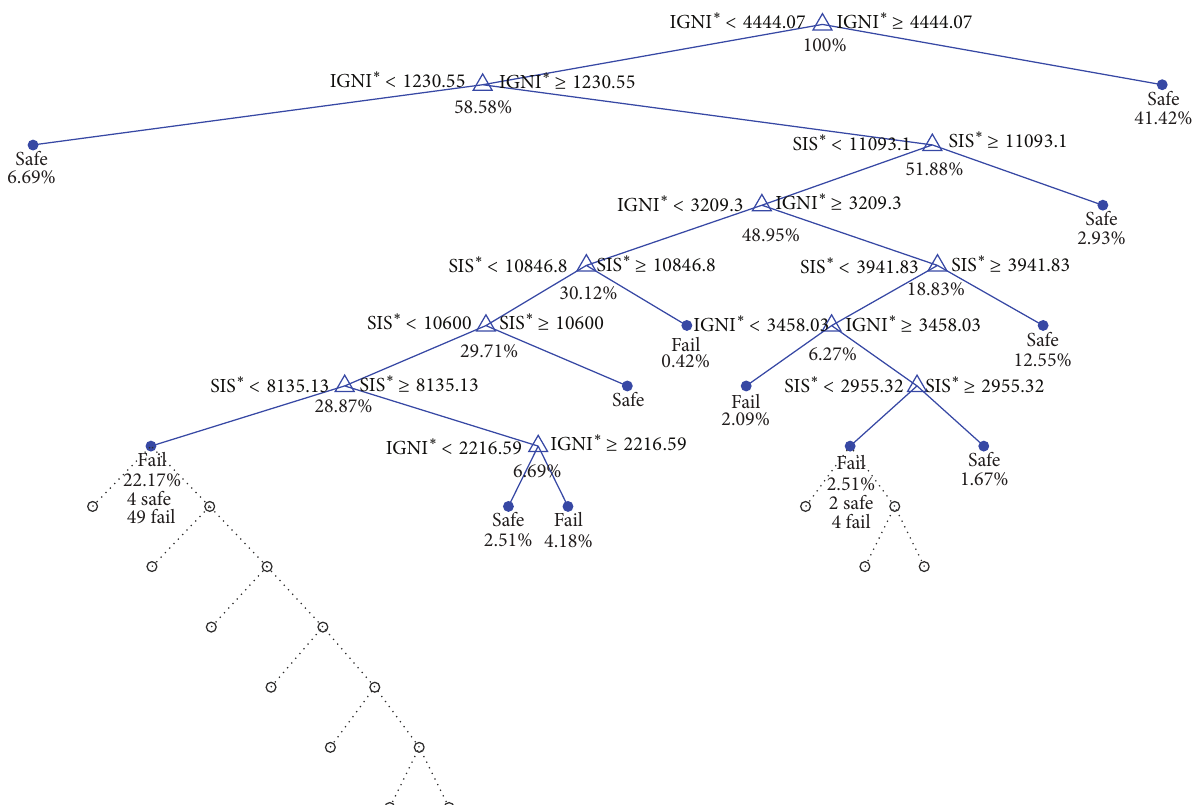
Figure 11: Decision tree fitted into clustering results data for the sequence [ INI SIS IGNI ] (sec) with pruning (SIS ∗ , IGNI ∗ : in coordinate system defined by principal components of the dataset).